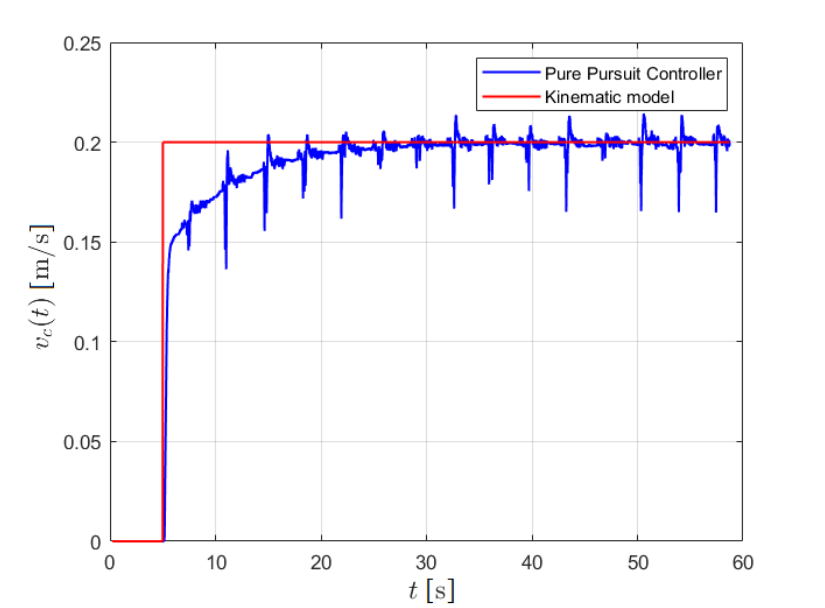
Figure 16. Linear velocity v c ( t ) of the